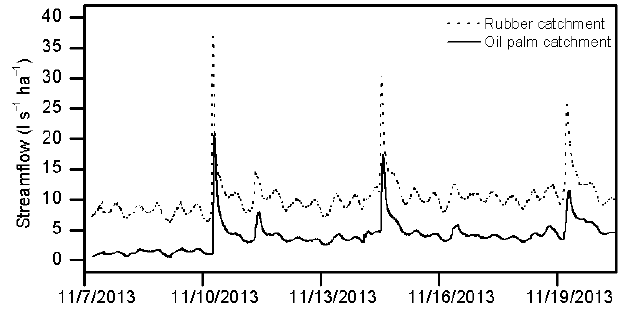
Fig. 2 . Streamflow patterns from oil palm dominated and rubber dominated catchments normalized by catchment area. Hydrographs from a two-week period (7 to 20 Nov 2013) encompassing both dry and rainy conditions.